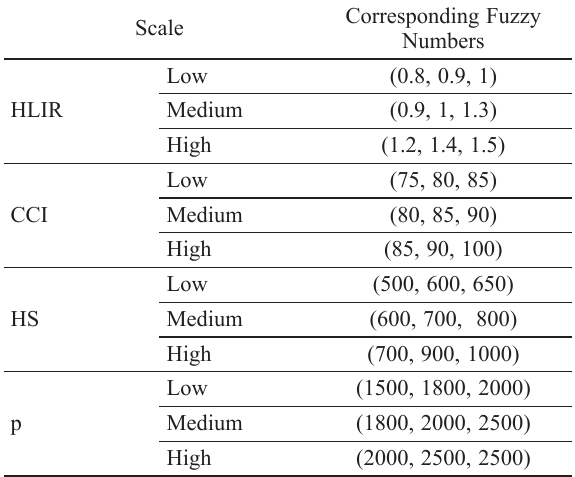
Table 3. Linguistic variables